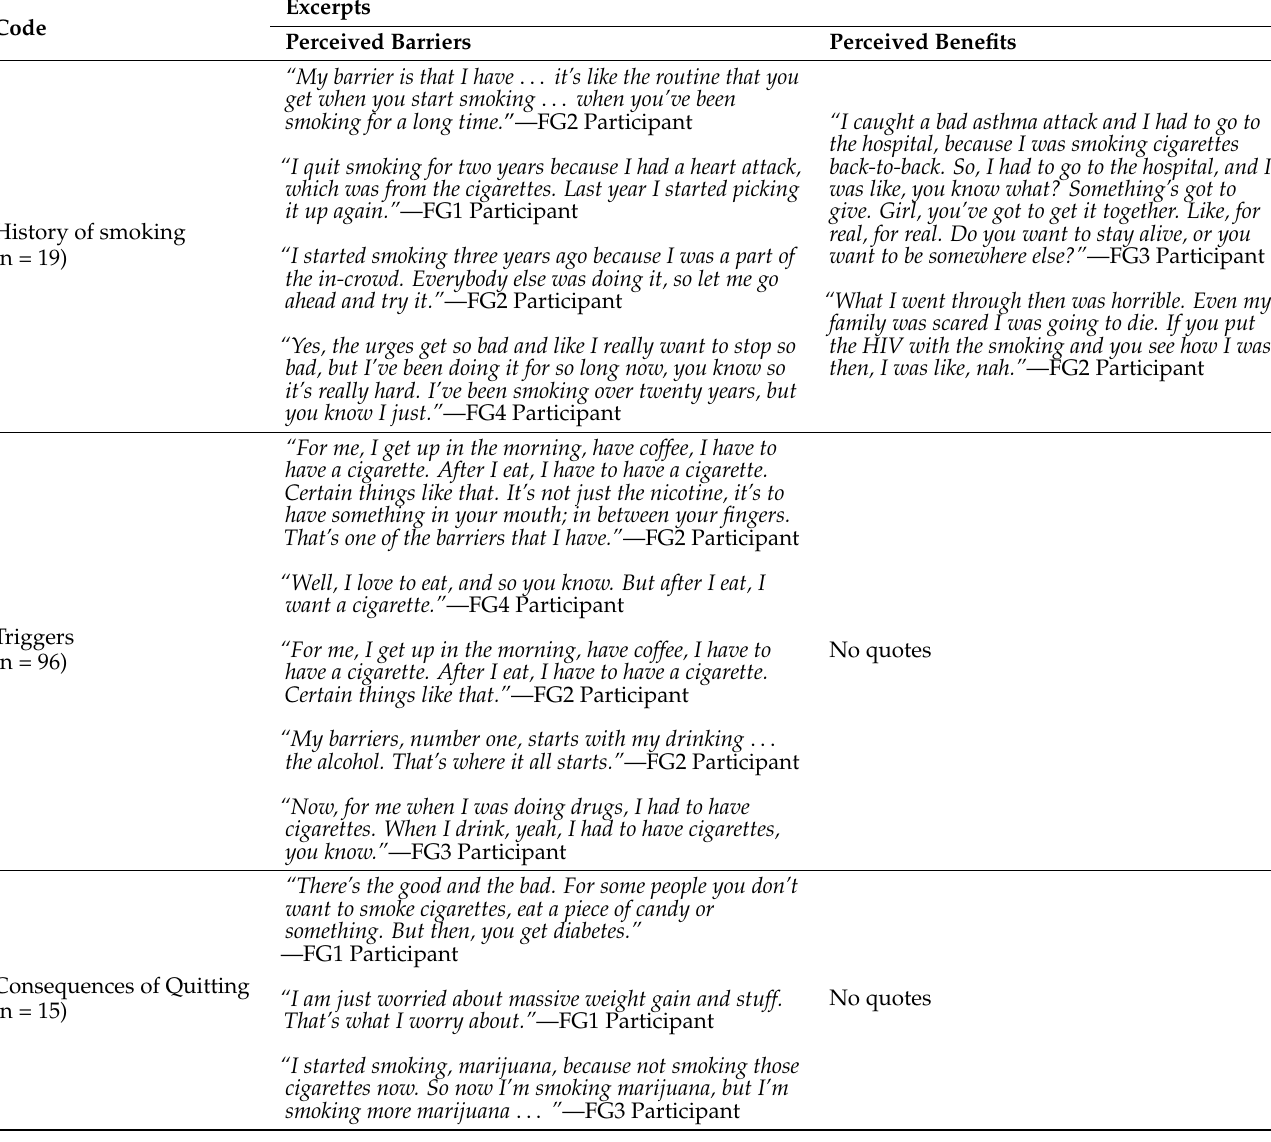
Table 2. Findings from the Focus Group